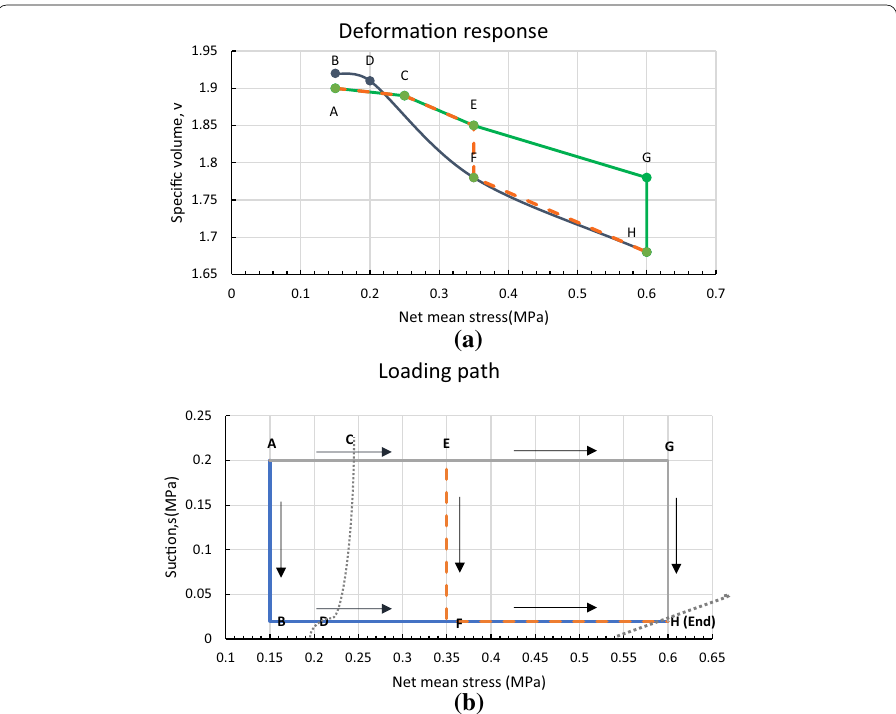
Fig. 8 a Response of model to suction-Specific volume-net mean stress. b. Response of model to suction- Stress